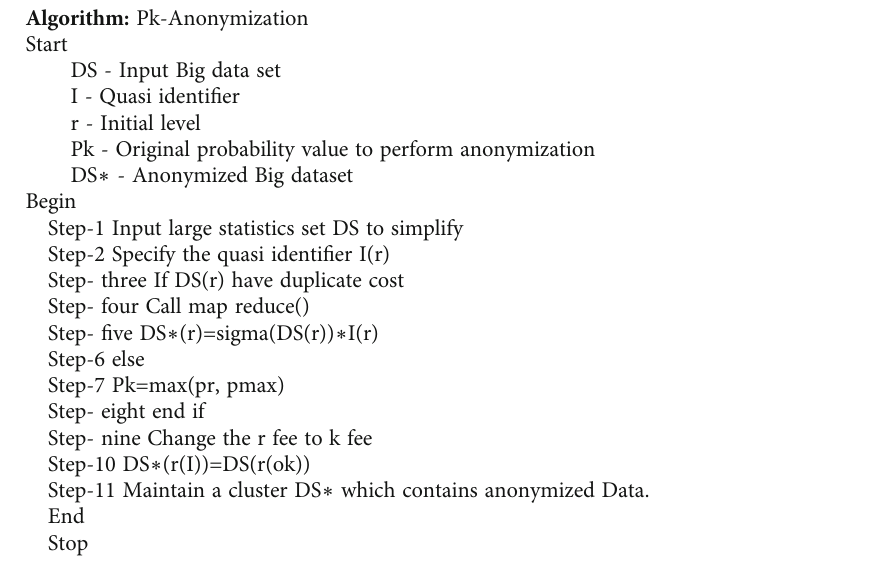
Algorithm 2: The proposed calculation to use the Pk-Anonymization method is portrayed